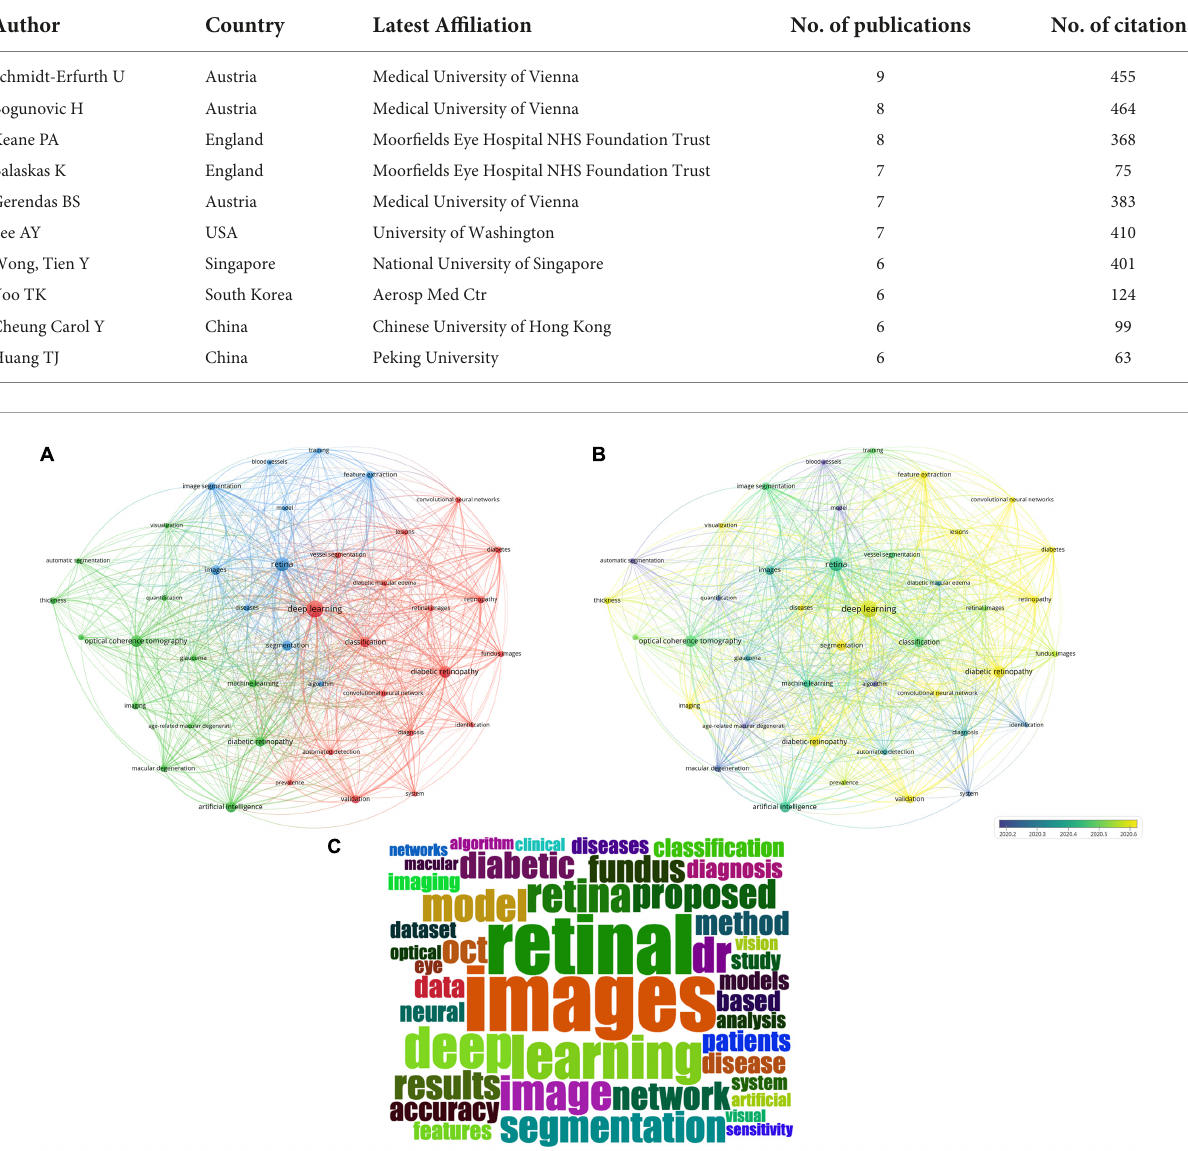
TABLE 3 Top 10 authors who published most and cited most in the field of artificial intelligence in retina.